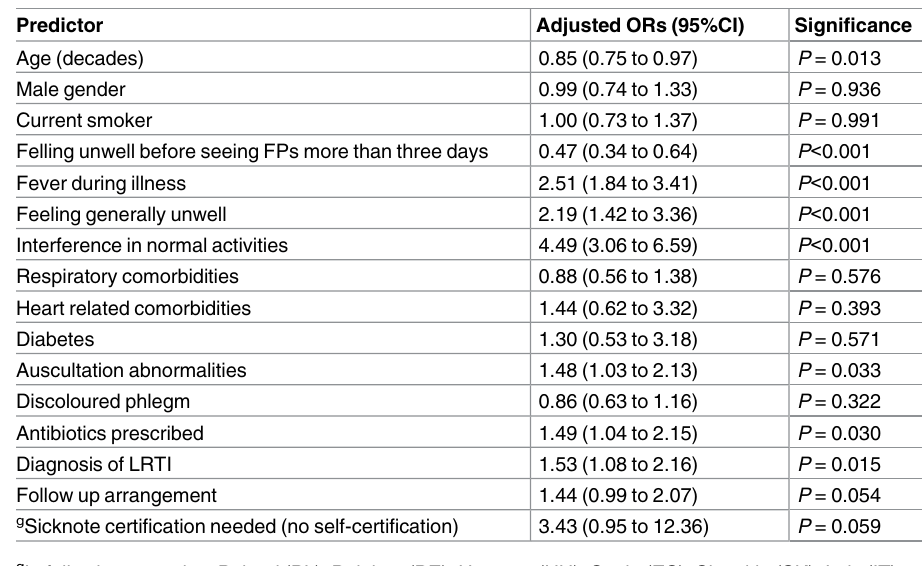
Table 4. Predictors of advising off work among working patients with LRTI. Odds ratios (ORs) were calculated based on multilevelmixed-effects binomial logistic regressionwith family practitioners (FPs) and